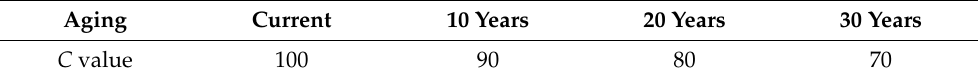
Table 7. Evolution of the Hazen–Williams C value over time for deteriorated pipes